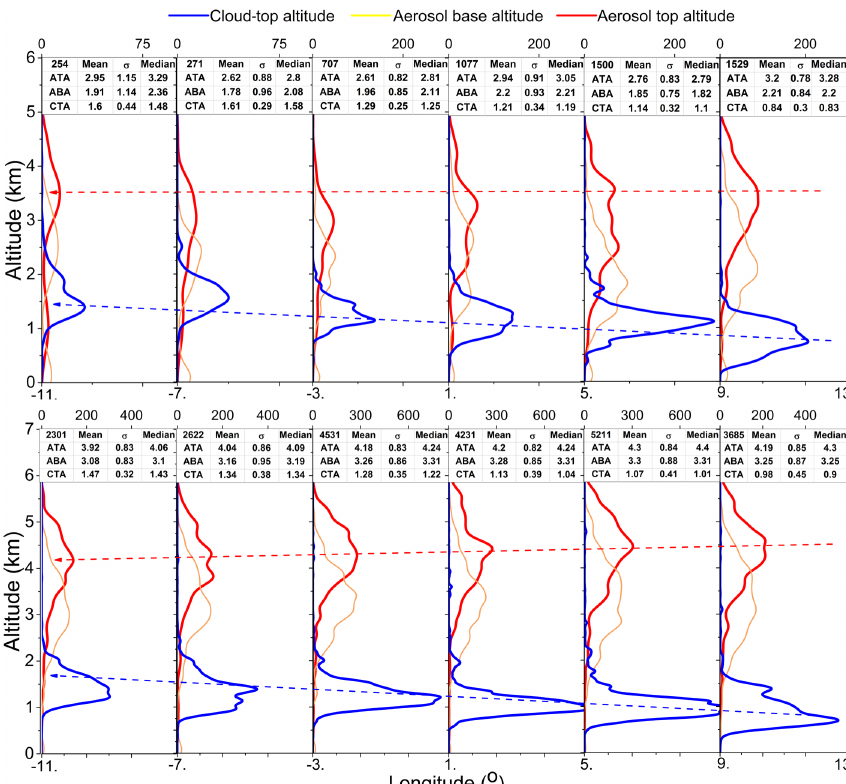
Figure 4. First and second rows of the panel present the histograms of the cloud-top altitude (CTA), the aerosol top altitude (ATA) and the aerosol base altitude (ABA) retrieved using CALIOP, as a function of longitude for two time periods: first row (May to July) and second row (August to October) from 2006 to 2010. The mean, median and standard deviation over 4 ◦ of longitude as well as the number of measurements are shown in the associated tables. The selected area extends from 30 ◦ S to 5 ◦ N and 12 ◦ W to 14 ◦ E over the South Atlantic Ocean